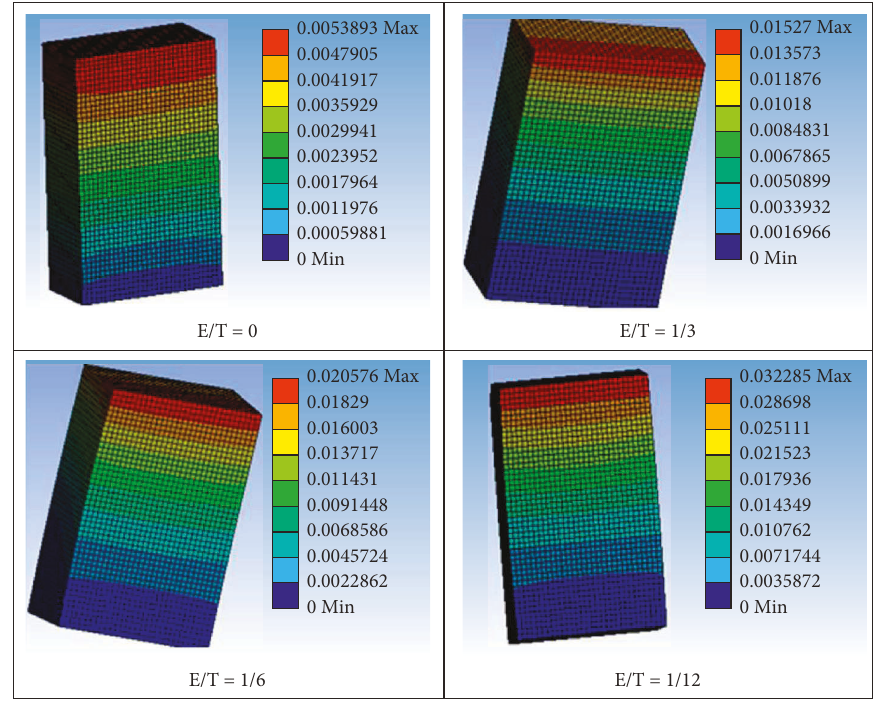
Figure 5: Deformation contours of specimens with H/T � 3. Table 3: Result summary of the finite element model of CSRE